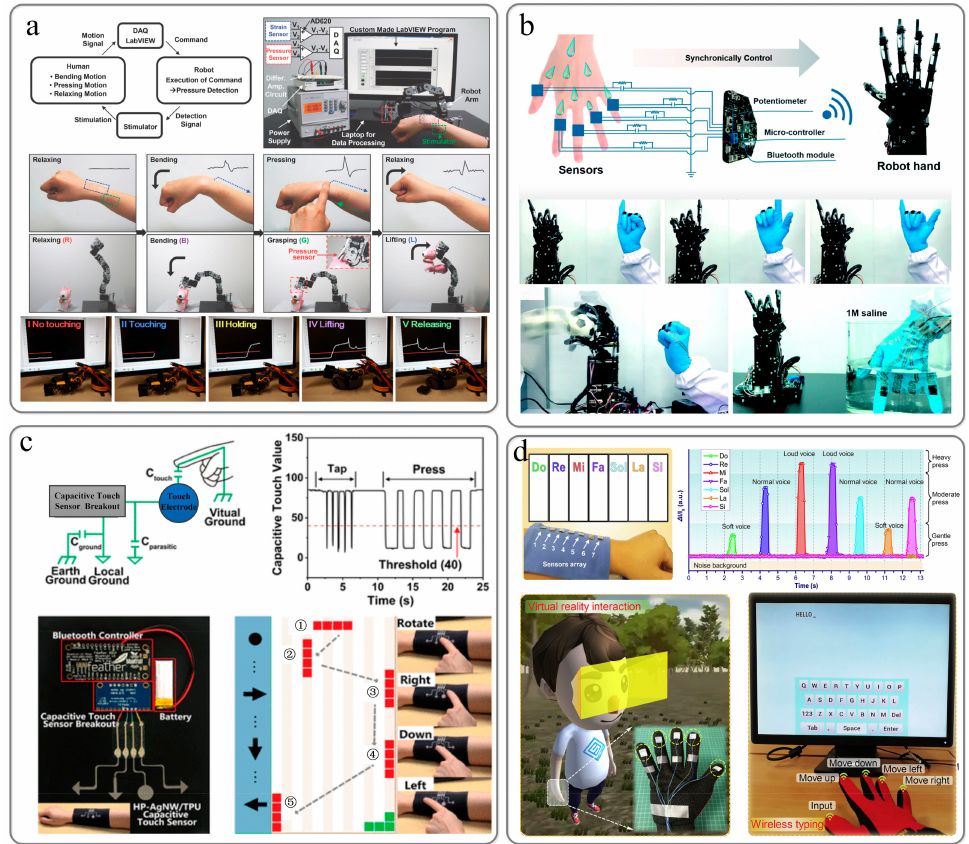
Figure 8. Flexible pressure sensor for Metaverse. ( a ) Obtain human physiological signals through flexible sensors and assist manipulator operation. Reprinted with permission from reference